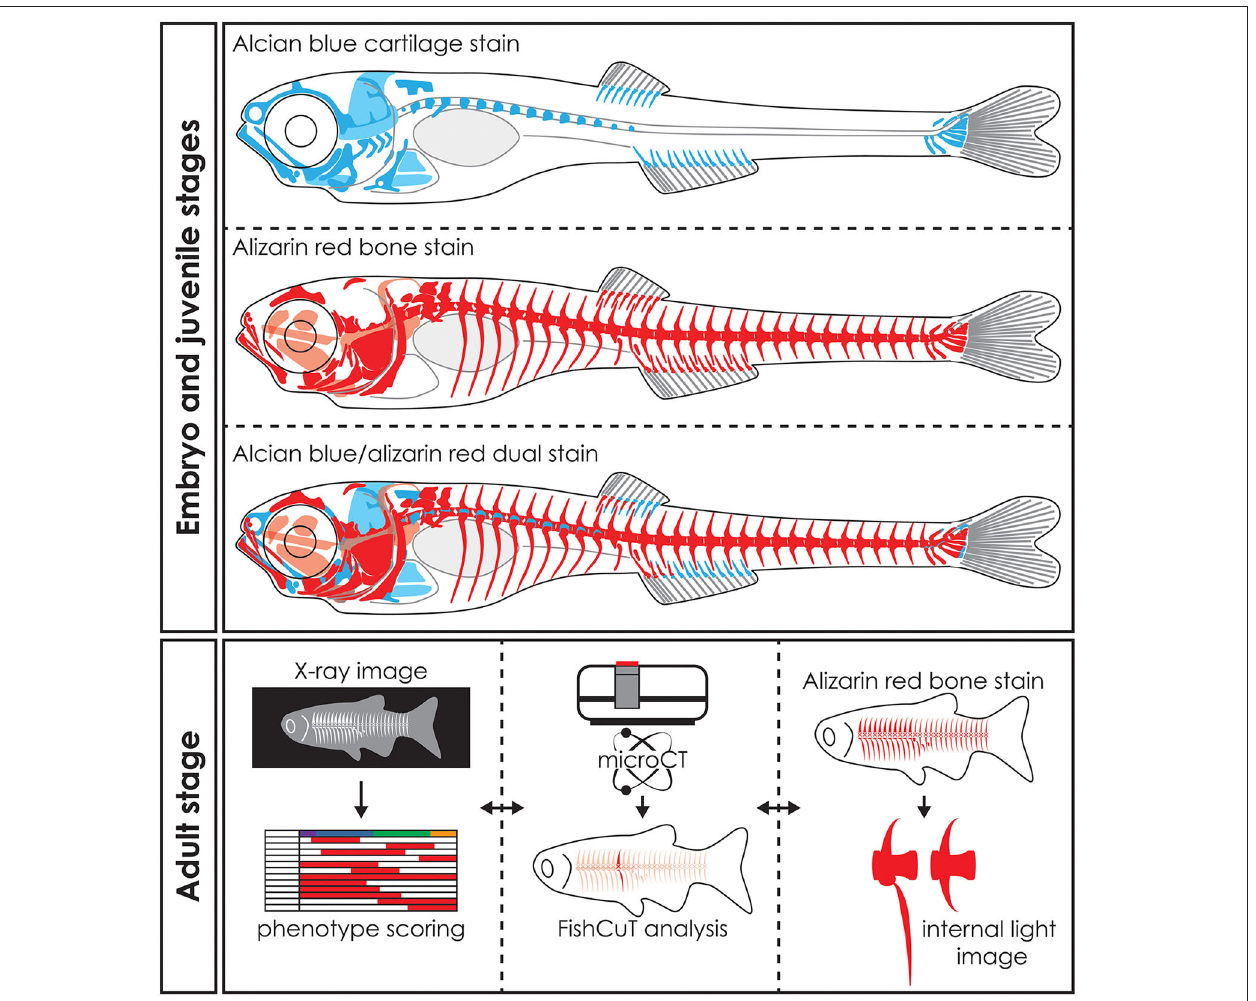
FIGURE 5 | Whole mount staining in early stages and applications of visualization techniques in adult zebrafish. Schematic representation of whole mount cleared and stained early stage zebrafish for cartilage with alcian blue, mineralized tissues (bone) with alizarin red and dual stained for both cartilage and mineralized tissues. Notice that only part of the skull, the basiventrals [for definition see Gadow and Abbott ( 243)] of the abdominal vertebrae and the fins endoskeleton are pre-formed in cartilage. Many bones in the skull and especially in the vertebral column are formed by direct intramembranous ossification. Images of adult skeletons taken by x-ray can be used to score for skeletal abnormalities, while microCT data can be used in an analysis program such as FishCuT to obtain quantitative data of bone measurements such as size, volume, thickness, and bone mineral density ( 80, 120). Bright field images or fluorescent images of whole mount cleared and stained zebrafish for mineralized tissues with alizarin red can be used to study skeletal abnormalities in detail. The three techniques are mostly used on euthanized and fixed specimens and thus can be applied on the same specimen sequentially. Moreover, the data procured by these visualization techniques can be integrated into a large data matrix and allows detailed phenotypic descriptions of zebrafish disease